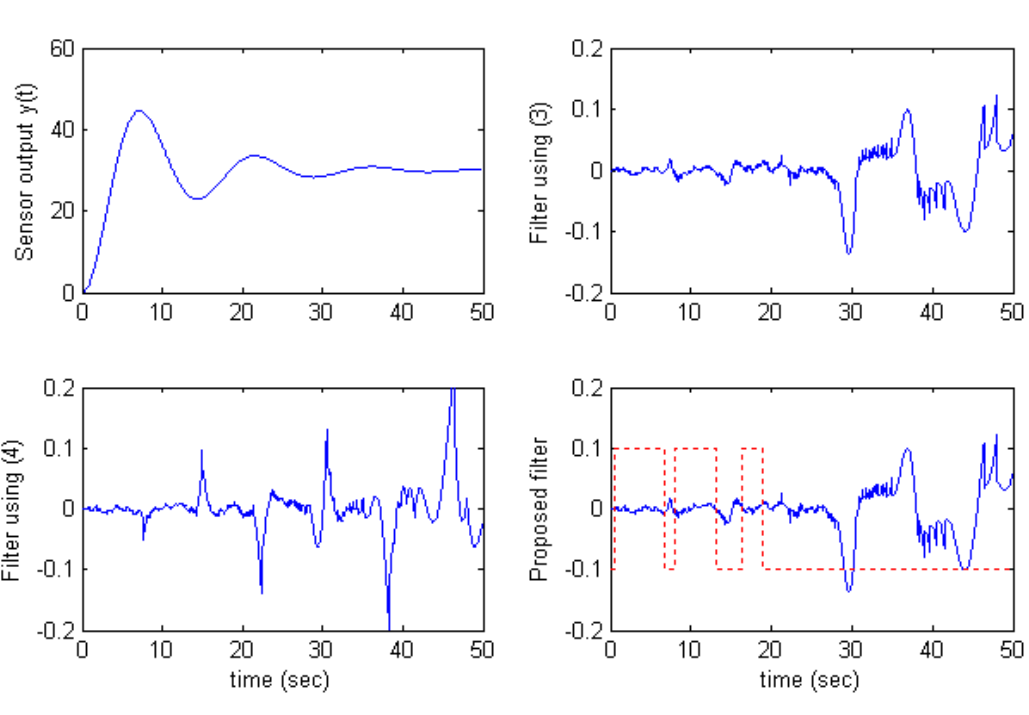
Figure 5. Estimation error of 3 filters